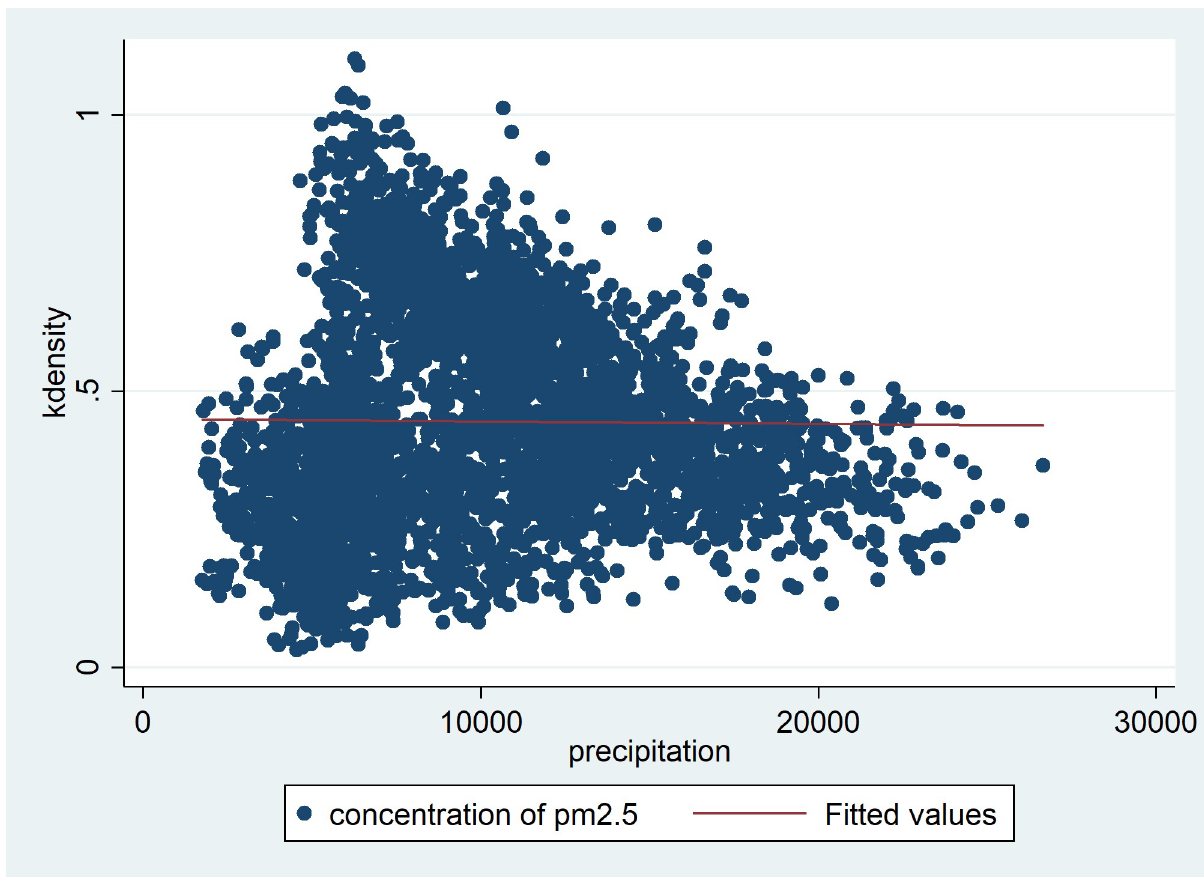
Fig 2. The relationship between precipitation and haze concentration of